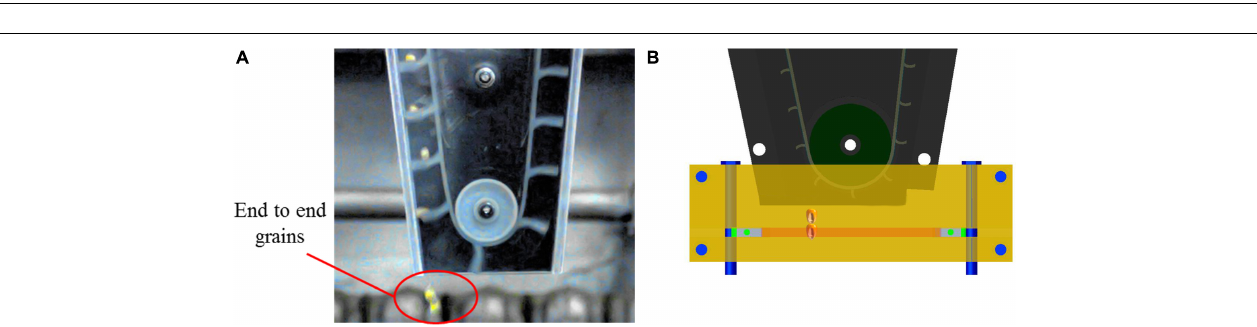
FIGURE 4 | Hardware system.